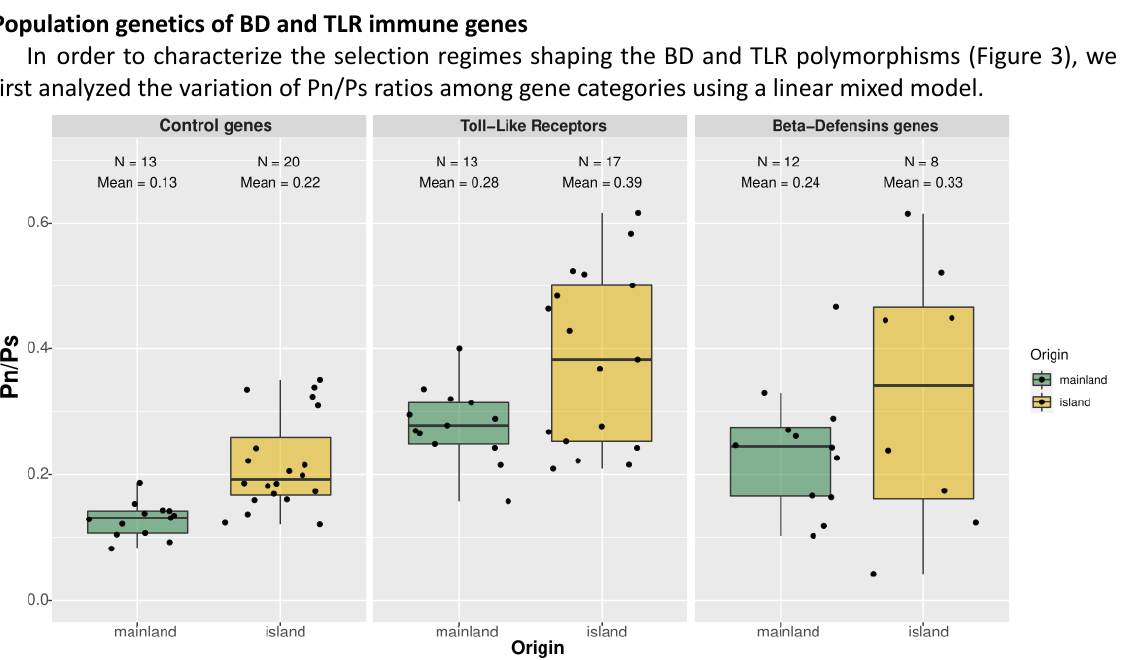
Figure 3: Pn/Ps according to species origin (mainland in green and insular in orange) for different gene categories under purifying selection. The number of species (N), and the mean Pn/Ps are shown for each